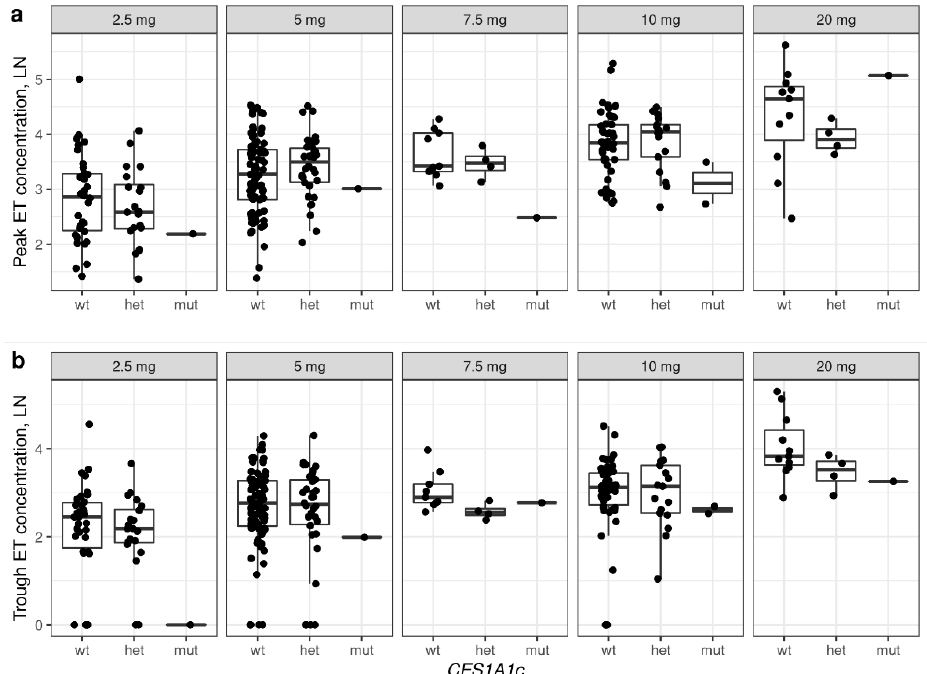
Figure 2. Peak ( a ) and trough ( b ) concentrations of enalaprilat, based on CES1A1c genotypes in patients receiving different doses of enalapril. The figure shows concentrations for which there was at least one observation for each genotype. ET — enalaprilat. WT — wild-type homozygous, wild-type heterozygous (WT/ CES1A1c ), mut — CES1A1c homozygous ( CES1A1c/CES1A1c ). Ln — natural logarithm.